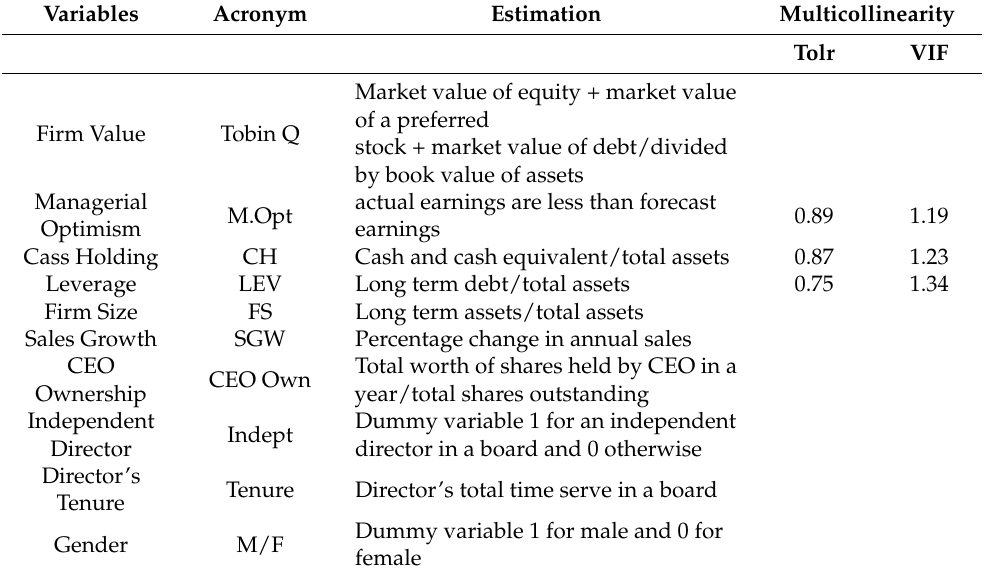
Table 1. Variables descriptions and their